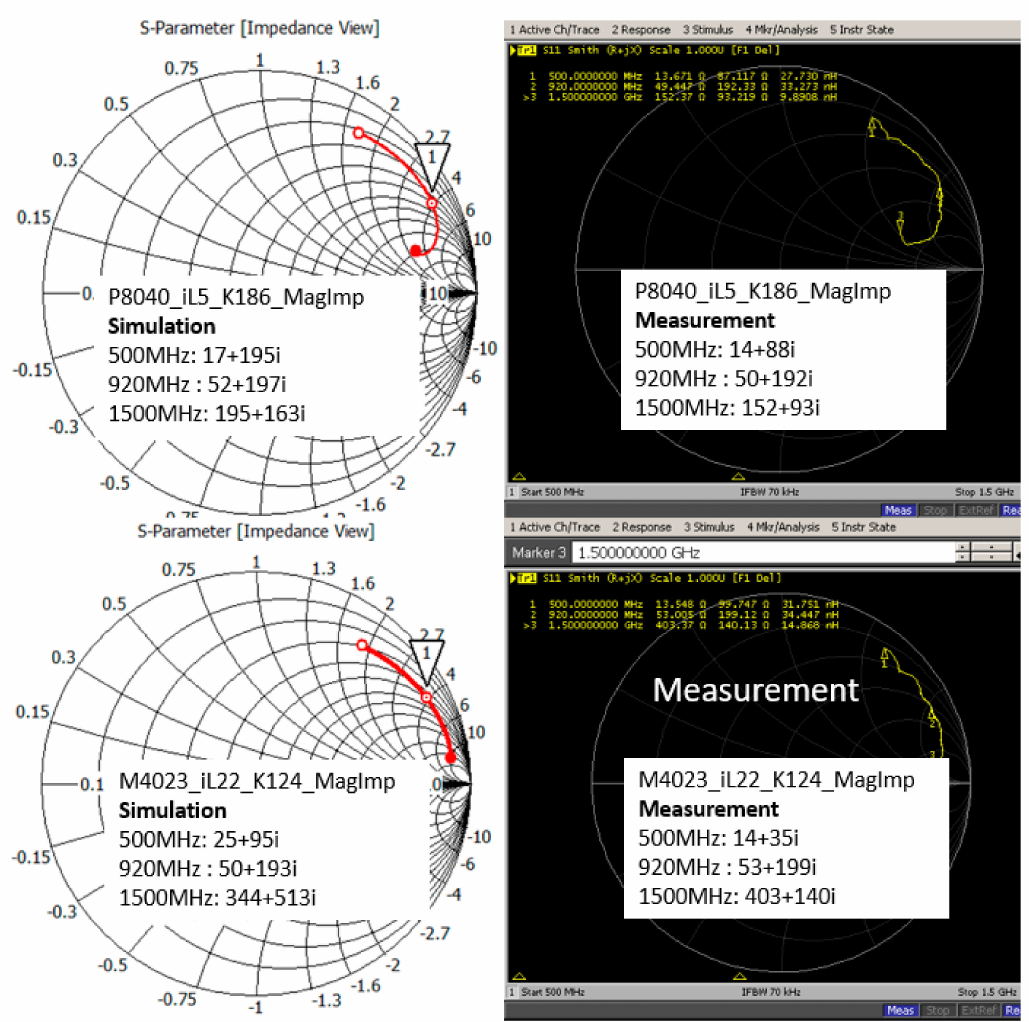
Figure 12. Simulation and measured impedances of the two CFTA M4023 and